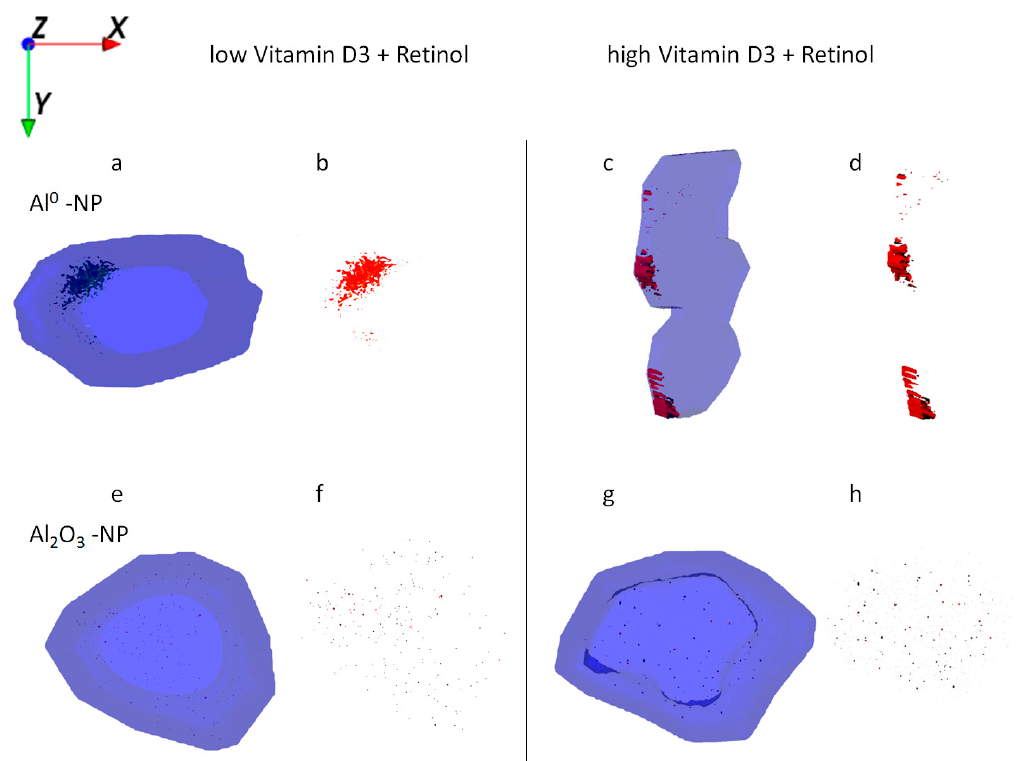
Figure 6. Ion reconstruction of a 3D depth profile (depth layer numbers: 50–250) of one single HaCaT cell exposed to Al NMs (upper panel a – d ) or Al 2 O 3 NMs (lower panel e – h ). The 3D depth profile of the cell is depicted as translucent blue. The images show the top-down view into the outline of a cell of a depth profile. In addition to NM treatment low vitamin D3 ( a , b , e , f ) and high vitamin D3 ( c , d , g , h ) were administered together with retinol. NM agglomerates are shown in detail next to their respective cell.